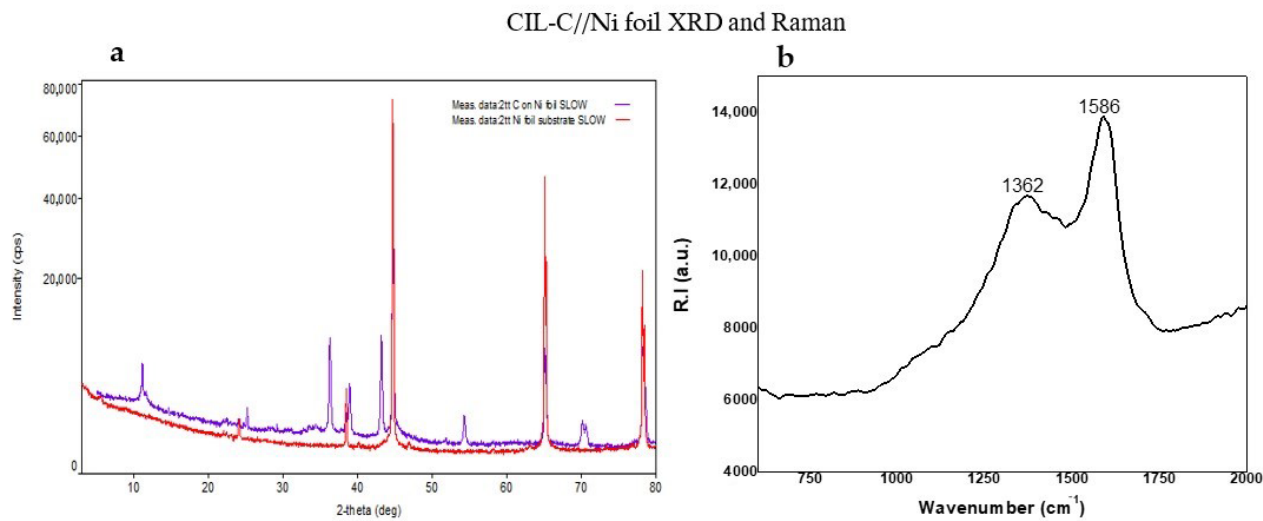
Figure 2. ( a ) Two-theta scans of L-CIL(Pro)-C on Ni foil (purple) and Ni foil substrate (red) with a grazing-incidence angle of 3–80 ◦ . ( b ) Raman spectrum of CIL(Pro)-C on Ni grazing-incidence angle of 3–80°. ( b ) Raman spectrum of CIL(Pro)-C on Ni surface.